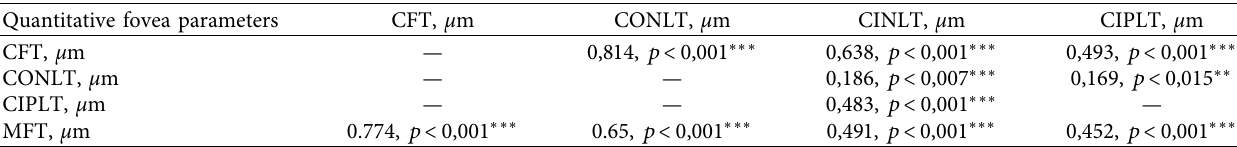
Table 3: Pearson’s correlations ( R 2 ) between the paired quantitative fovea parameters at ERM (total Groups 1–5) labeled the corresponding Quantitative fovea parameters CFT, µ m CONLT, µ m CINLT, µ m CIPLT, µ m